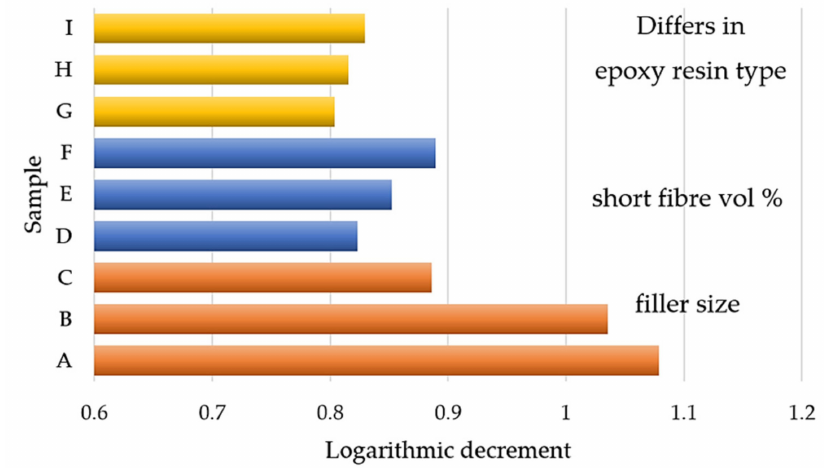
Figure 11. Logarithmic decrements of particle composites: Samples